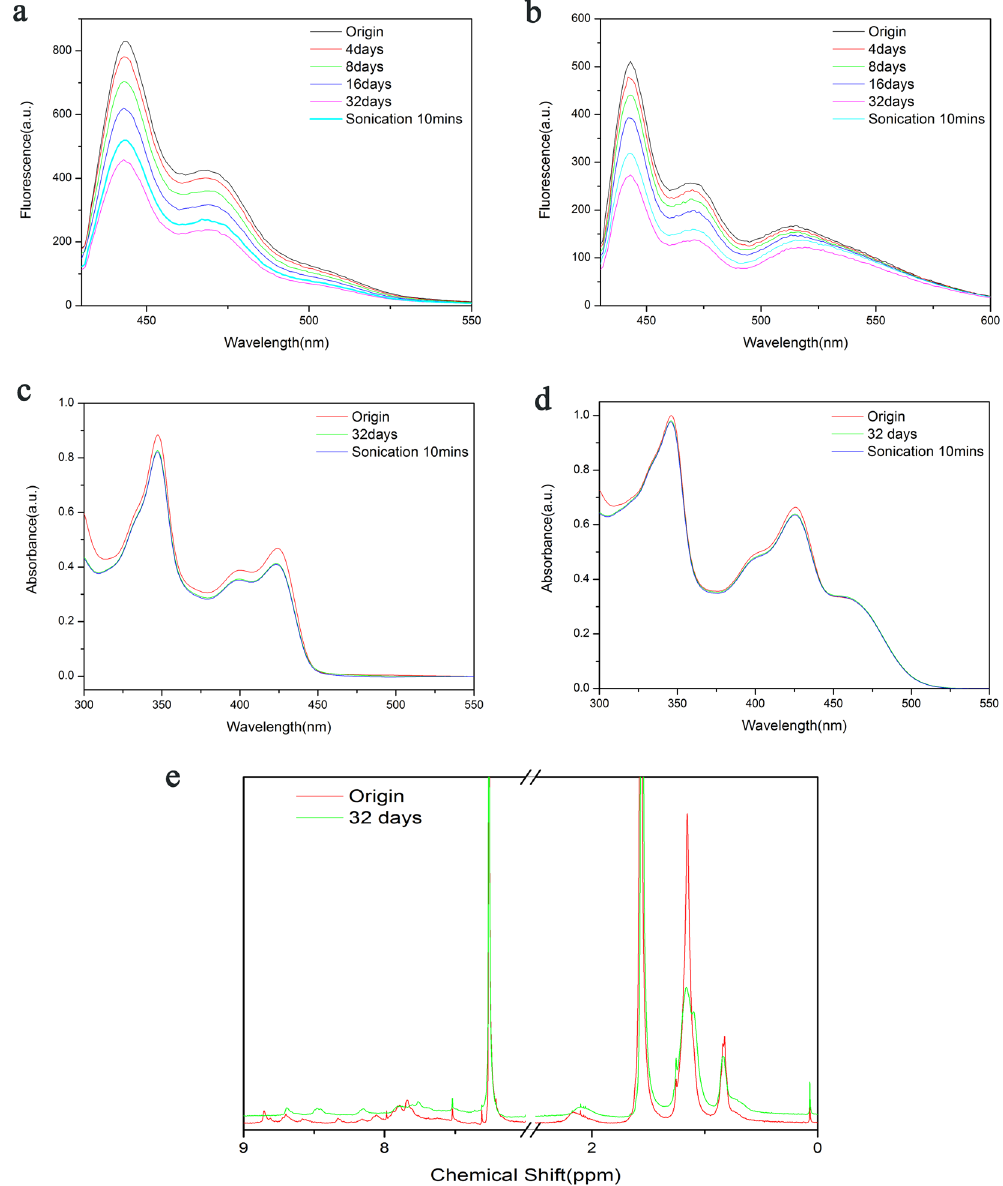
Figure 2. Optical spectra of PFluAnt solution and mixture solution as well as and NMR spectra of PFluAnt solution. ( a ) Fluorescence spectra of PFluAnt solution under room illumination after different standing time. ( b ) Fluorescence spectra of PFluAnt&PFOBT mixture under room illumination after different standing time. ( c ) UV-Vis absoption spectra of PFluAnt solution under room illumination after 32 days’ standing time. ( d ) UV-Vis absoption spectra of PFluAnt&PFOBT mixture under room illumination after 32 days’ standing time. ( e ) NMR spectra of original PFluAnt solution in CDCl 3 and that after 32 days’ room